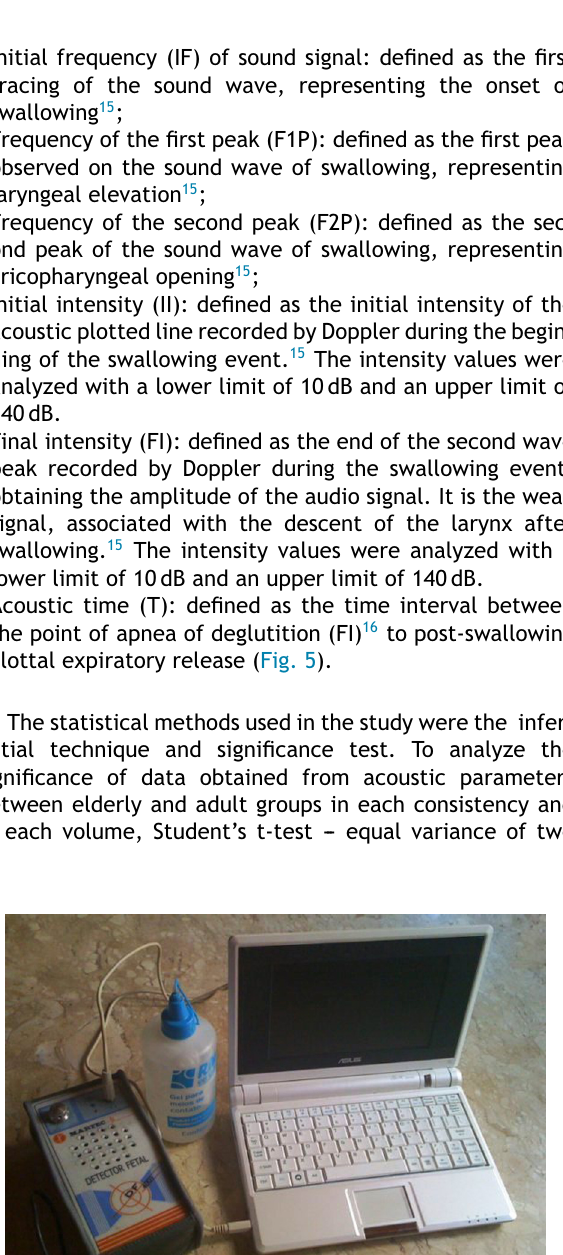
Figure 1 Classification of consistencies --- National Dysphagia Diet Guidelines (2002).